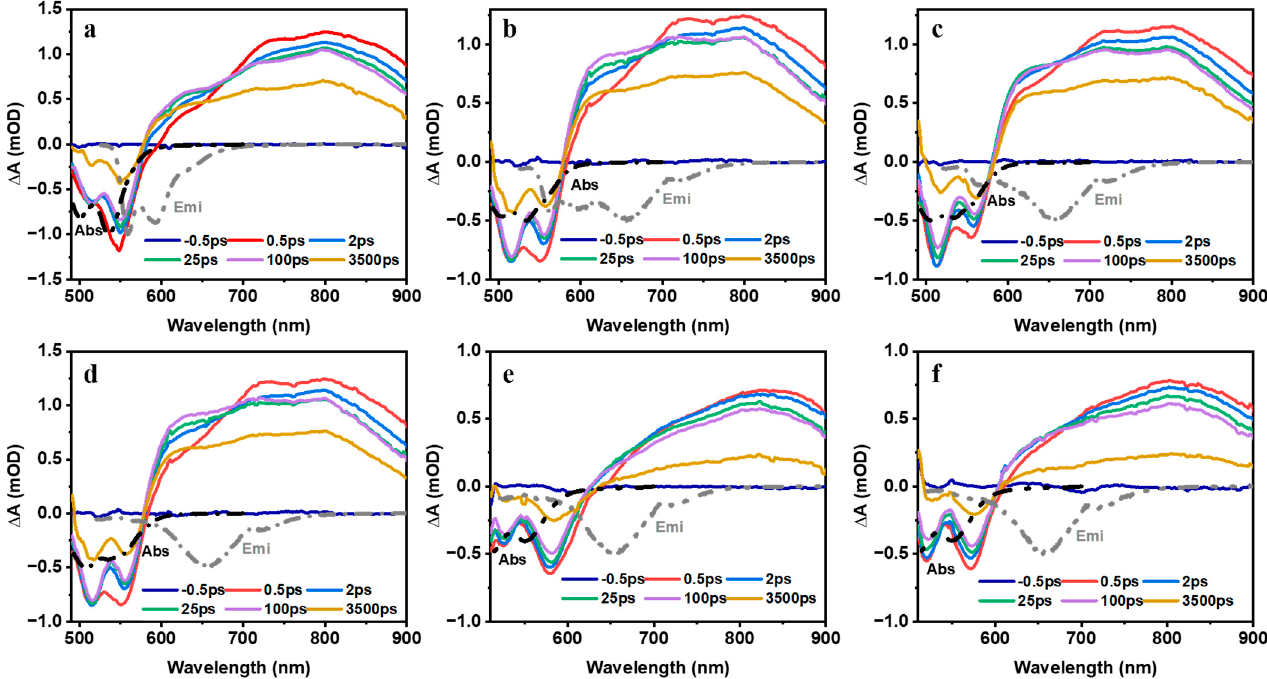
Figure 5. The transient absorption spectra of the PDI-III at different time delays with different water percentages: ( a ): 0%; ( b ): 10%; ( c ): 20%; ( d ): 30%; ( e ): 40%; and ( f ): 50%.